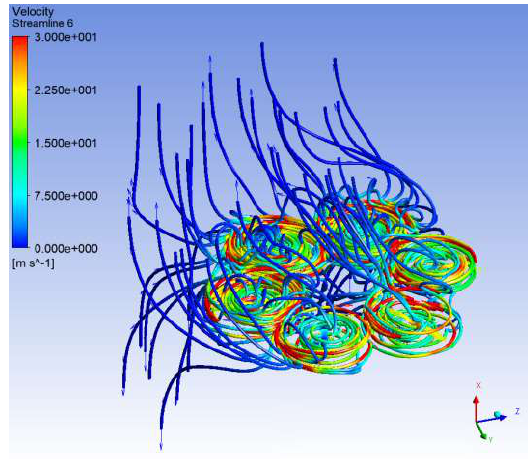
Figure 37. Streamlines and pressure contours on the